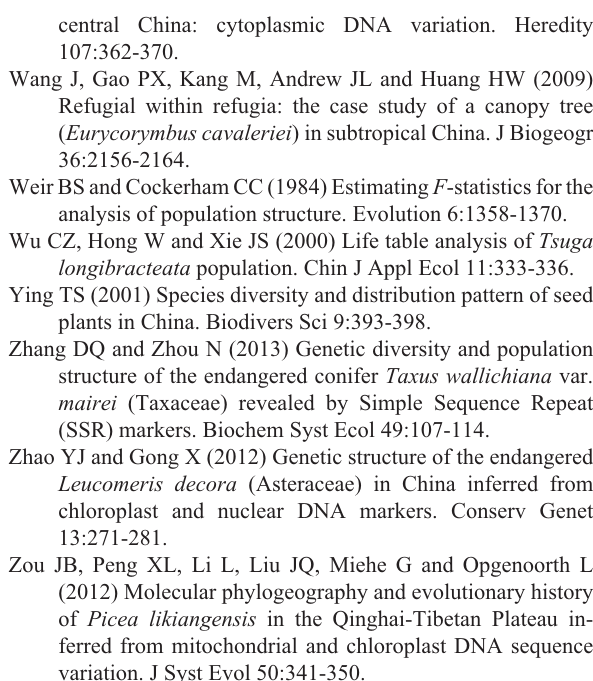
Table S1 - Frequency and diversities of cpSSR haplotypes within Nothotsuga longibracteata groups. Table S2 - Haplotypes and their distribution in popu- lations of cpSSRs. Table S3 - Genetic differentiation ( F classes of three populations estimated using the infinite al- leles